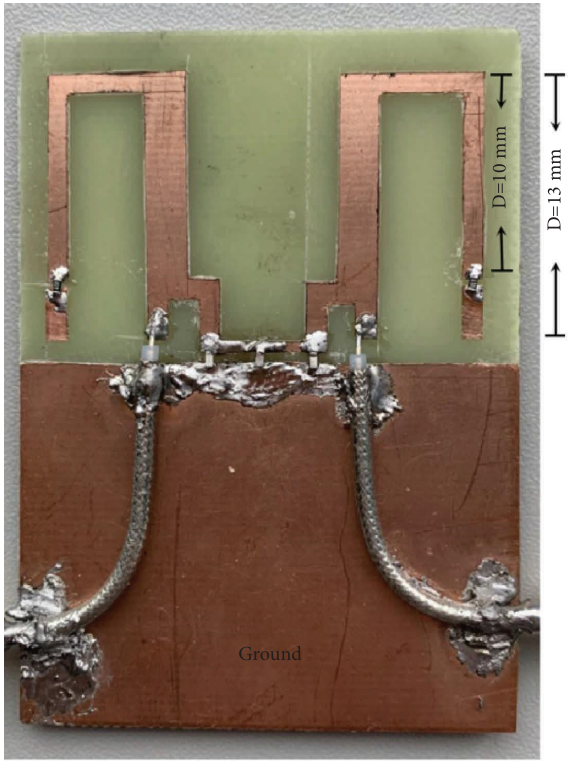
Figure 5: Photograph of the proposed frequency-reconfguration decoupling antenna